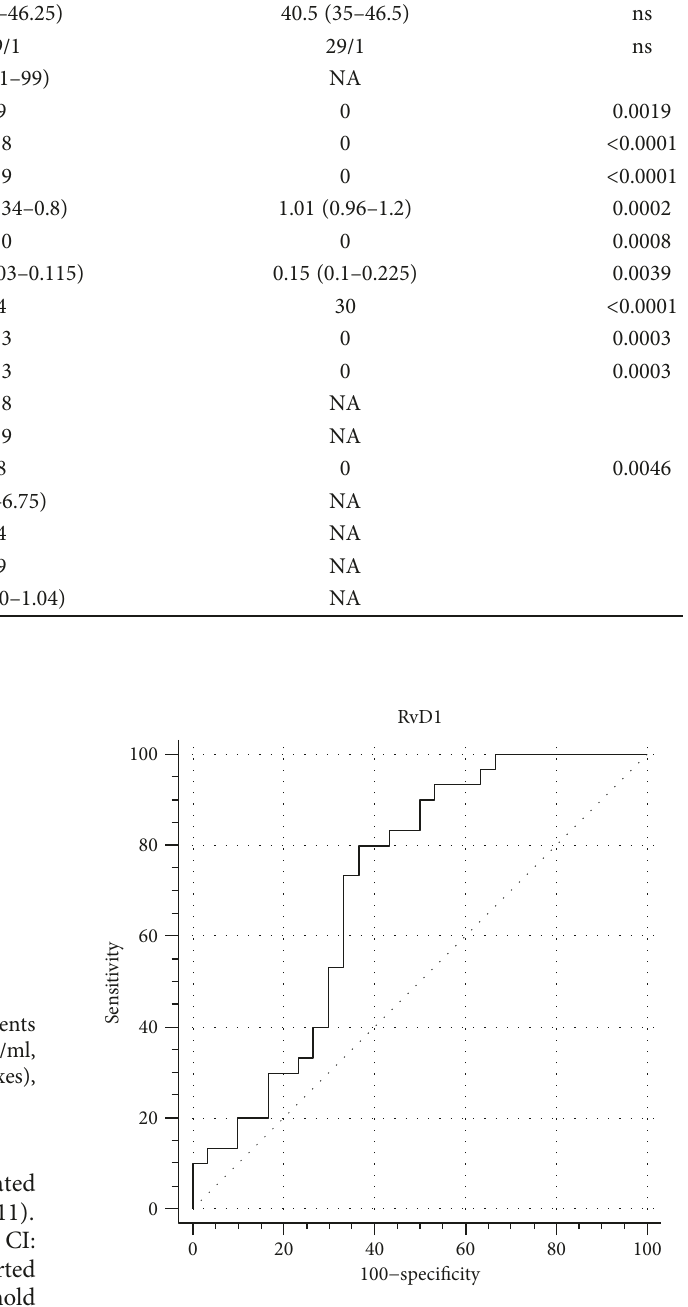
Figure 2: ROC curve for RvD1. Area under the curve (AUC) value is 0.71 (95% CI: 0.58 to